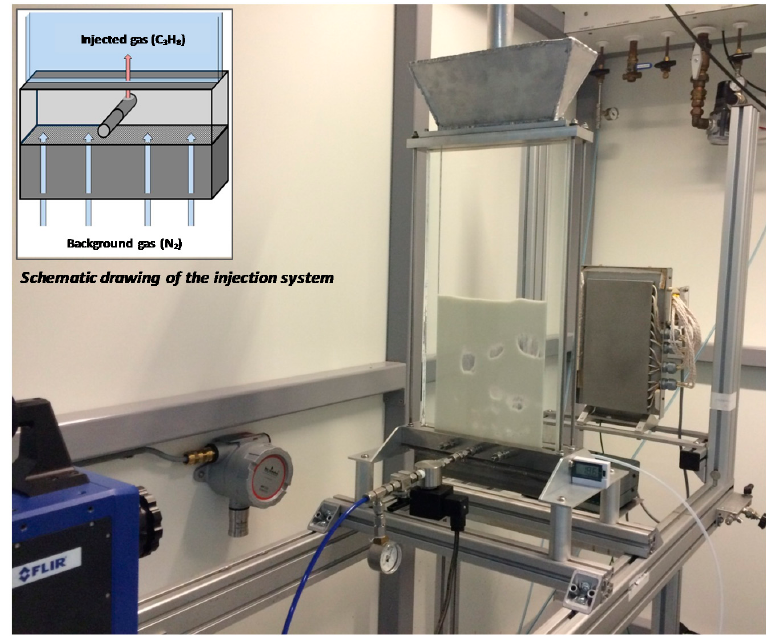
Figure 4. Picture of the scaled-up setup used in this work for mass transfer measurements after optimization of the IR technique and detailed drawing of the injection system for selective feeding of tracer gas.